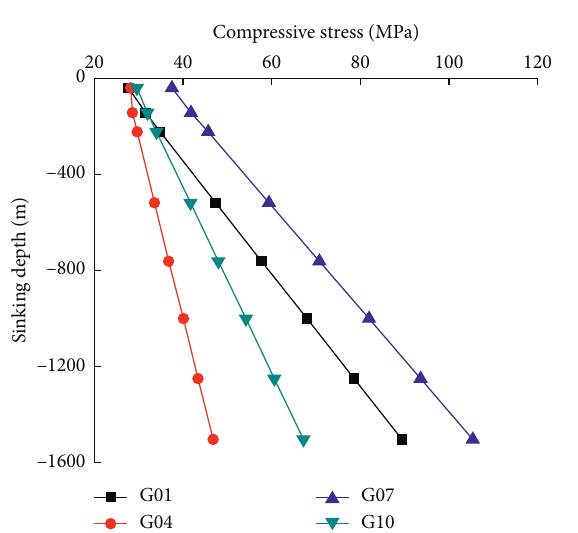
Figure 4: Theoretical stress curve of upper corner column under different working conditions.